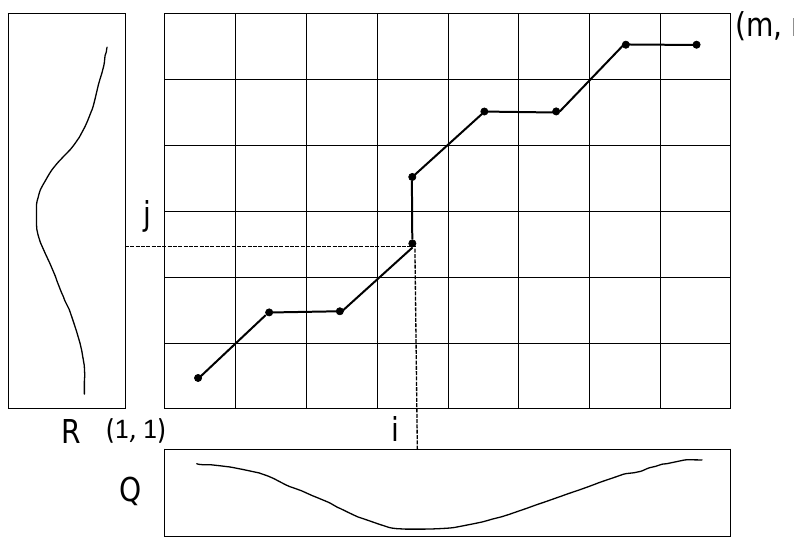
Figure 6. Using the DTW algorithm to find the least-cost path in the cost matrix. R represents the reference sequence with a length of m , and Q represents the query sequence with a length of n